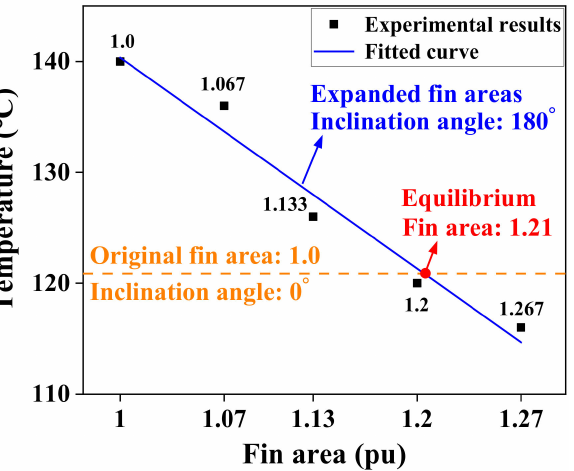
Figure 15. Winding temperature comparison of original fin at an inclination angle of 0 ◦ and expanded fins at 180 ◦